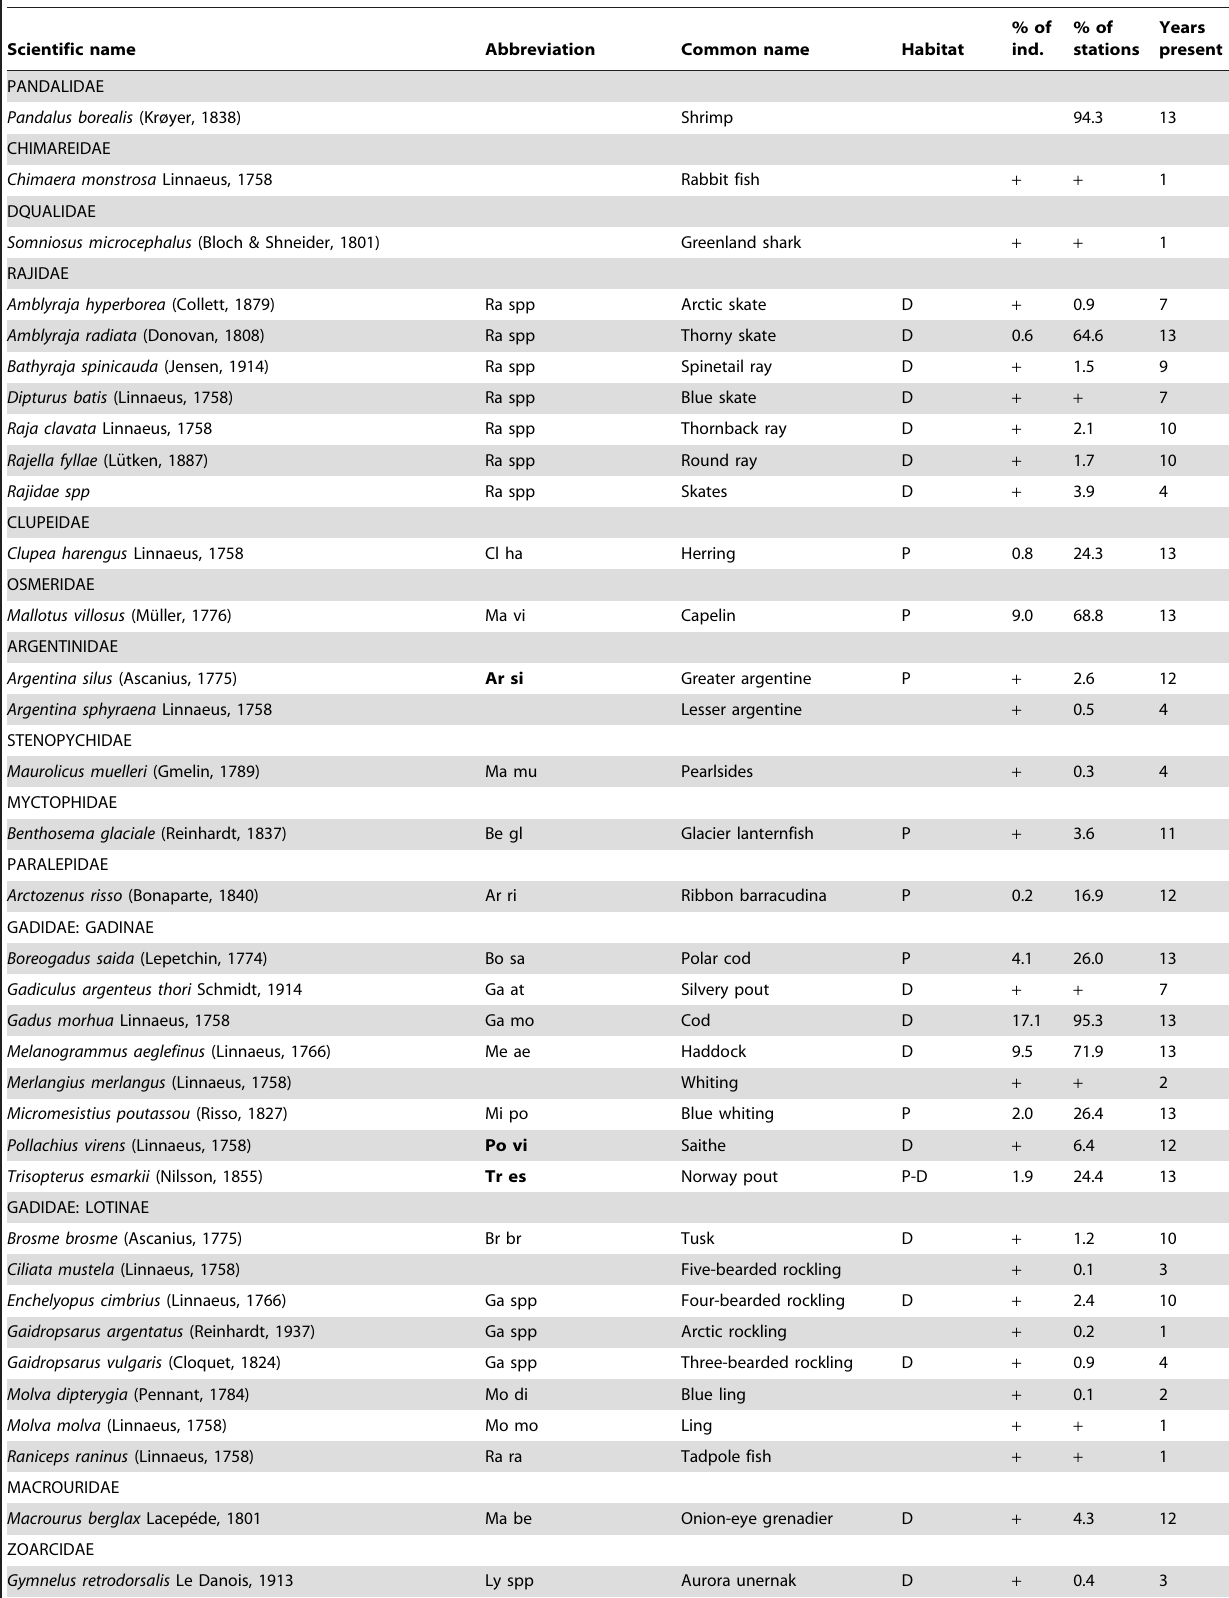
Table 2. Taxa identified in the SW Barents Sea in spring 1992 2